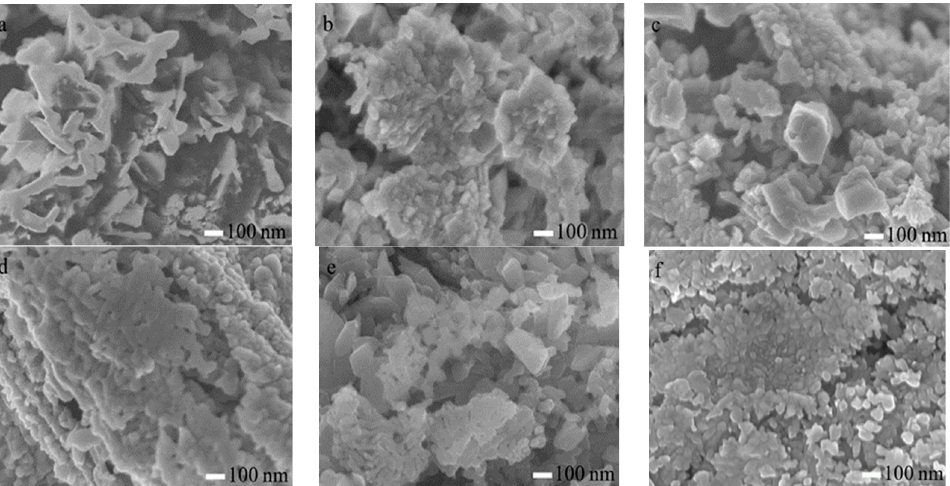
Figure 3. SEM images of the surface of the CuO thin films deposited at different substrate tempera- tures (50 k magnification), T s , K: ( a ) 600, ( b ) 625, ( c ) 650, ( d ) 675, ( e ) 700, ( f ) 725.